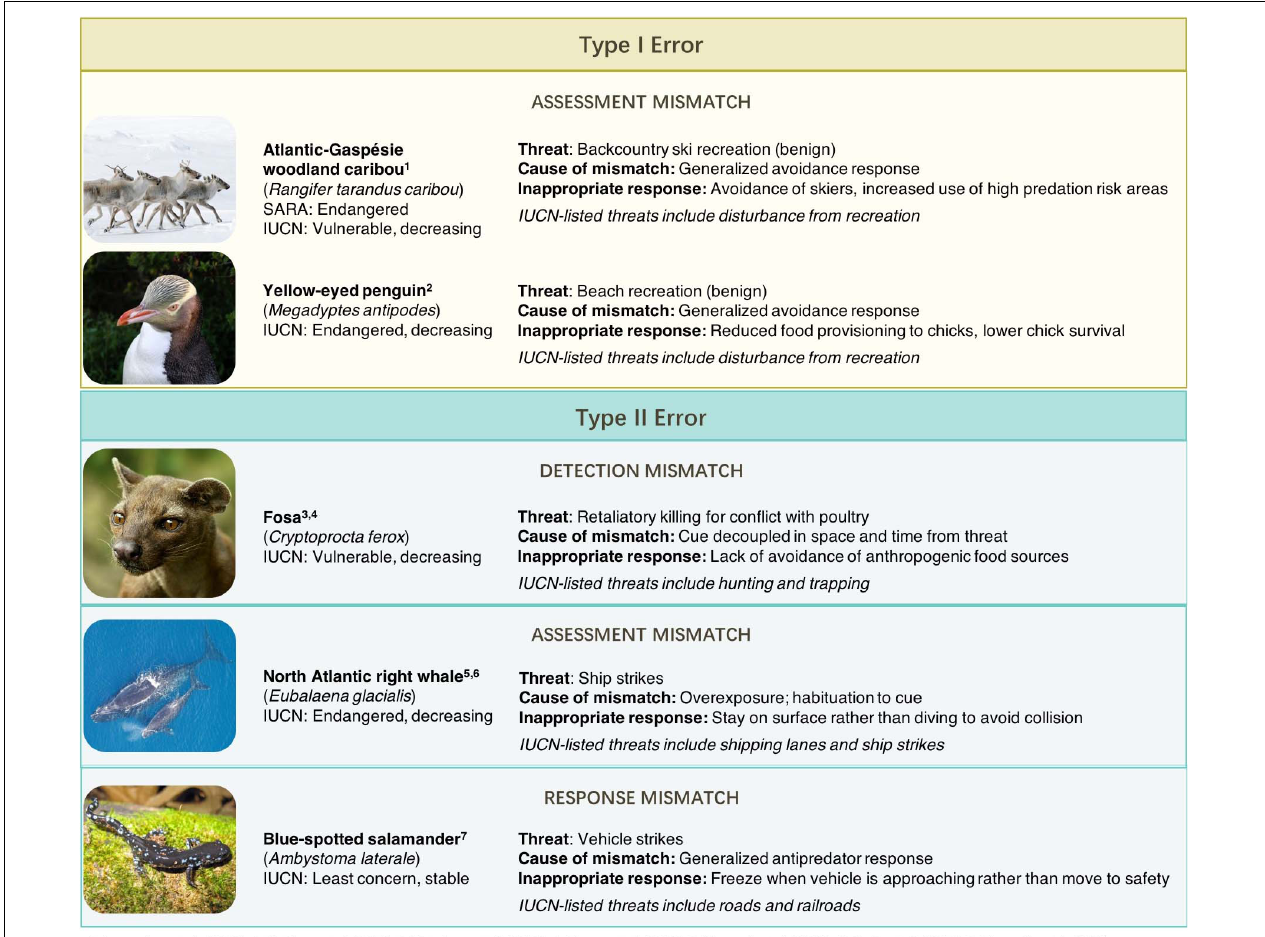
FIGURE 2 | Conservation implications of risk-response mismatch. Examples of species whose declines may be accelerated as a result of Type I and Type II errors in anthropogenic risk detection, assessment, and response. Global species status shown from the International Union of Concerned Scientists (IUCN); Canadian population status shown for Atlantic-Gaspésie woodland caribou from the Species at Risk Act (SARA).